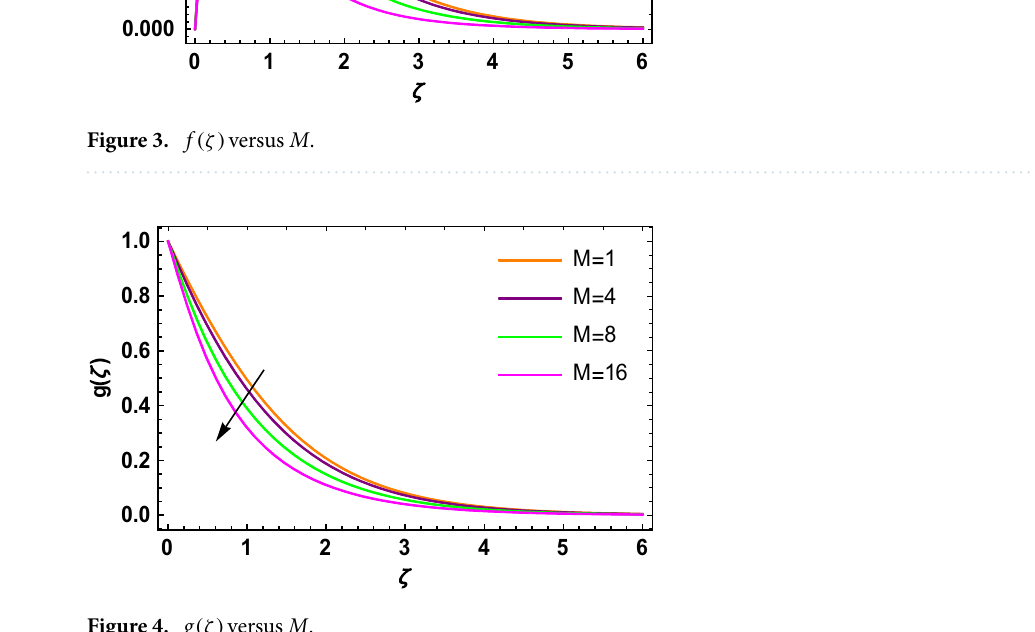
Figure 4. g (ζ) versus M .